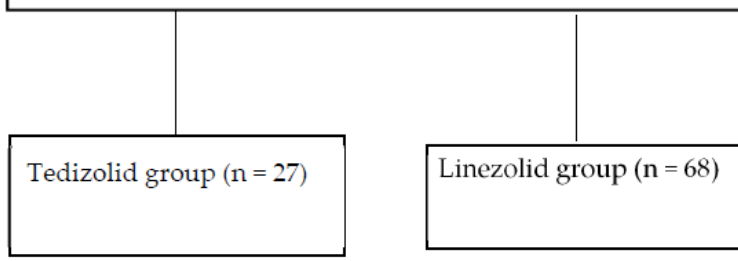
Figure 1. Shows the flow-chart of this study. Table 1. Clinical characteristics of The patients treated with LZD and TZD was 68 and 27 were included in our study (Table 1). The duration in the TZD group were longer than those in the LZD group (9.0